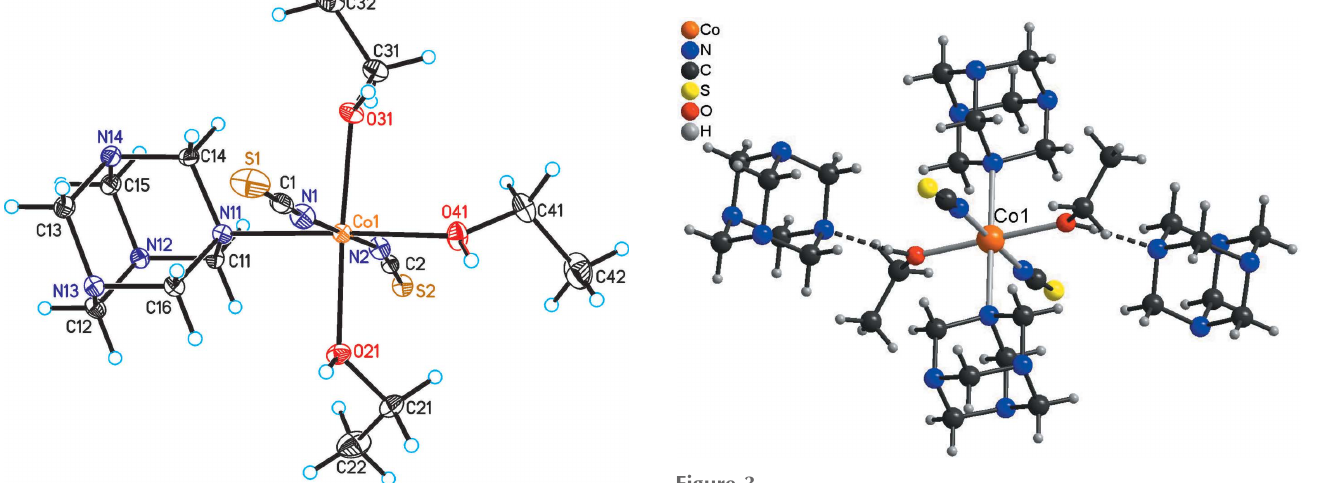
Figure 3 View of the discrete complex in compound 1 built up of Co1, which is connected to two urotropine solvate molecules via intermolecular O— H (cid:2)(cid:2)(cid:2) N hydrogen bonding (shown as dashed lines).